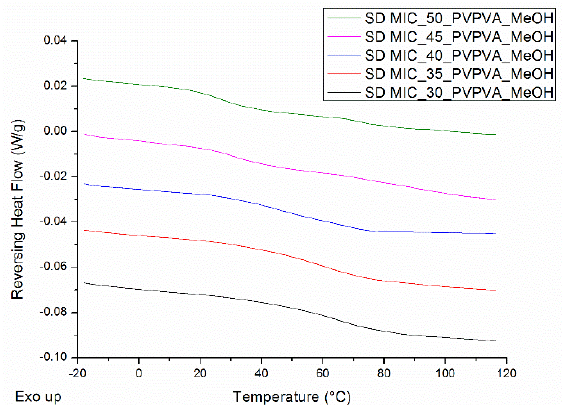
Figure 9. mDSC thermograms of spray dried (SD) MIC-PVP-VA systems, with drug loadings from 30% (black) to 50% (green) by intermediate steps of 5%. The RHF signals are shown as arbitrary units.